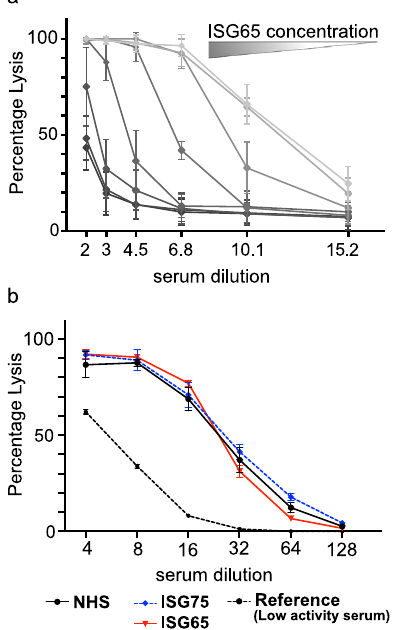
Fig. 4 | ISG65 prevents haemolysis following activation of the alternative pathway, but not the classical pathway. a Haemolysis assay (AP50 test) mea- suring the lysis of rabbit erythrocytes in human serum in the presence of ISG65 (left)and ISG75(right)followingactivationofthealternativecomplementpathway ( n =3 technical replicates; data points are presented as mean values±SD). ISG65, but not ISG75, considerably reduced haemolysis in a concentration-dependent manner. Colour gradients indicate protein dilutions ranging from 7.5 to 0 µ M. b Haemolysisassay(CH50test)measuringthelysisofsensitisedsheeperythrocytes in human serum in the presence of ISG65 (red solid line), ISG75 (dashed blue line) and without added inhibitors (NHS, normal human serum; solid black line) fol- lowing activation of the classical complement pathway ( n =4 technical replicates; data points are presented as mean values±SD). At 24 µ M, neither ISG65 nor